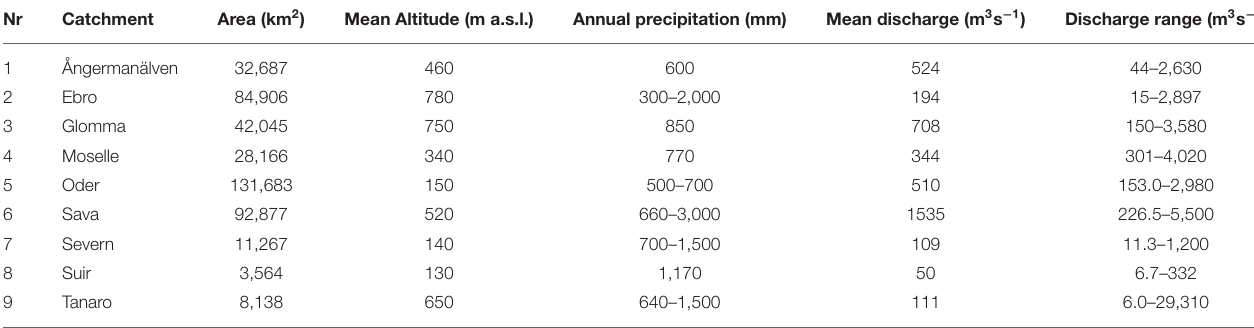
TABLE 1 | Characteristics of studied